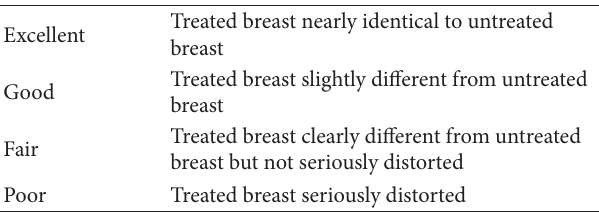
Table 1: Harvard scale (4-point Likert